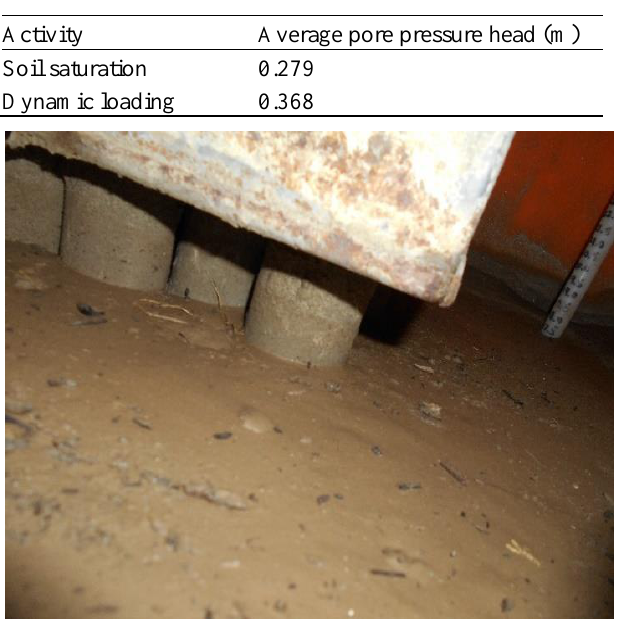
Average Pore Pressure Heads in Treated 1-g Physical Model-